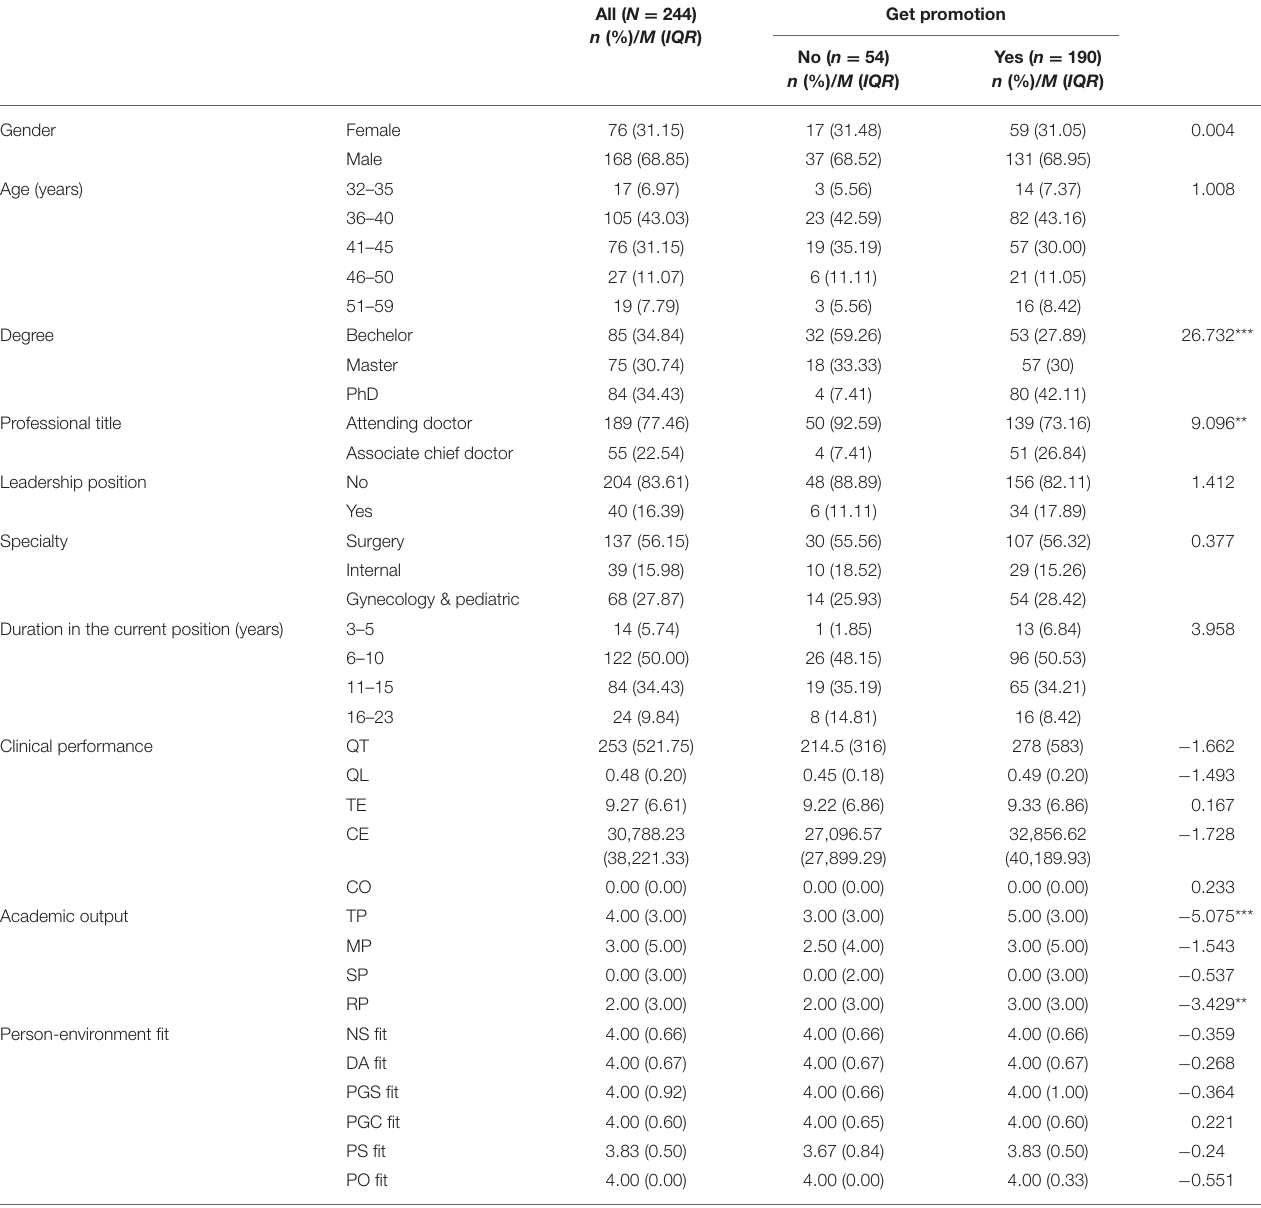
TABLE 1 | The characteristics and main indicators of the promoted and unpromoted